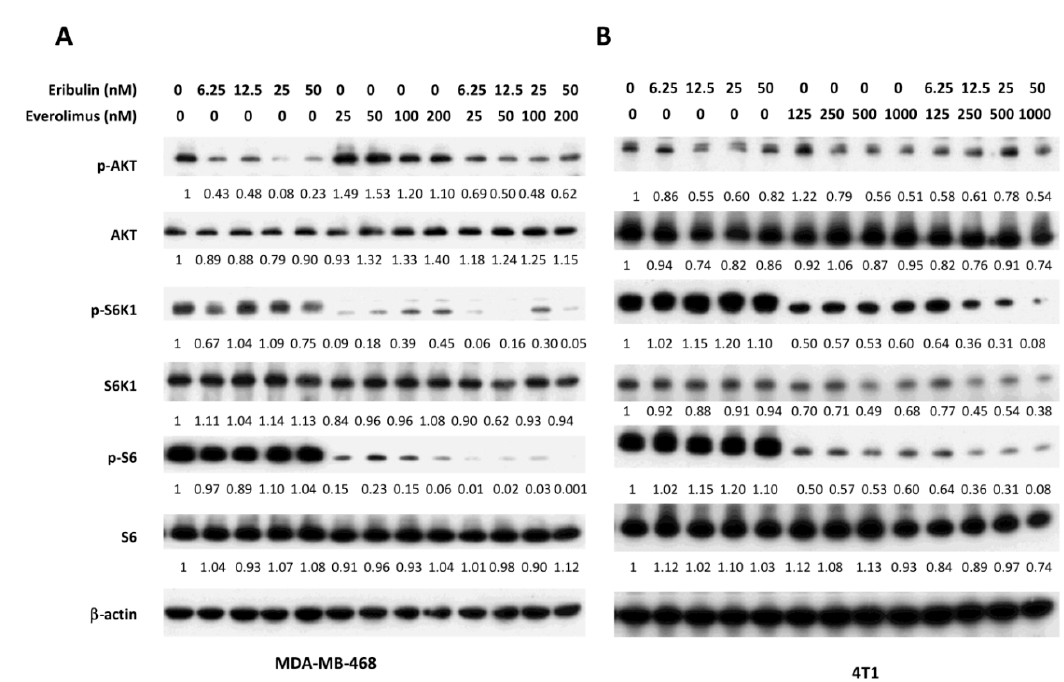
Figure 3. Combined treatment of eribulin and everolimus enhances the reduction of p-S6. MDA-MB-468 ( A ) and 4T1 ( B ) cells were treated with eribulin and everolimus at indicated concentrations, either alone or in combination. Cells were collected 24 h later and analyzed by Western blot for the expression of p-AKT, p-S6K, and p-S6. Numbers below the corresponding blot represent densitometric analysis normalized to β -actin.